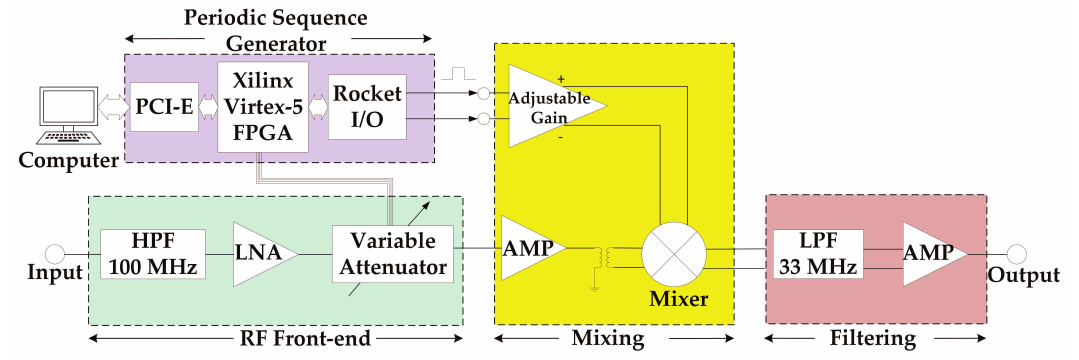
Figure 4. Block diagram of the proposed circuit board based on